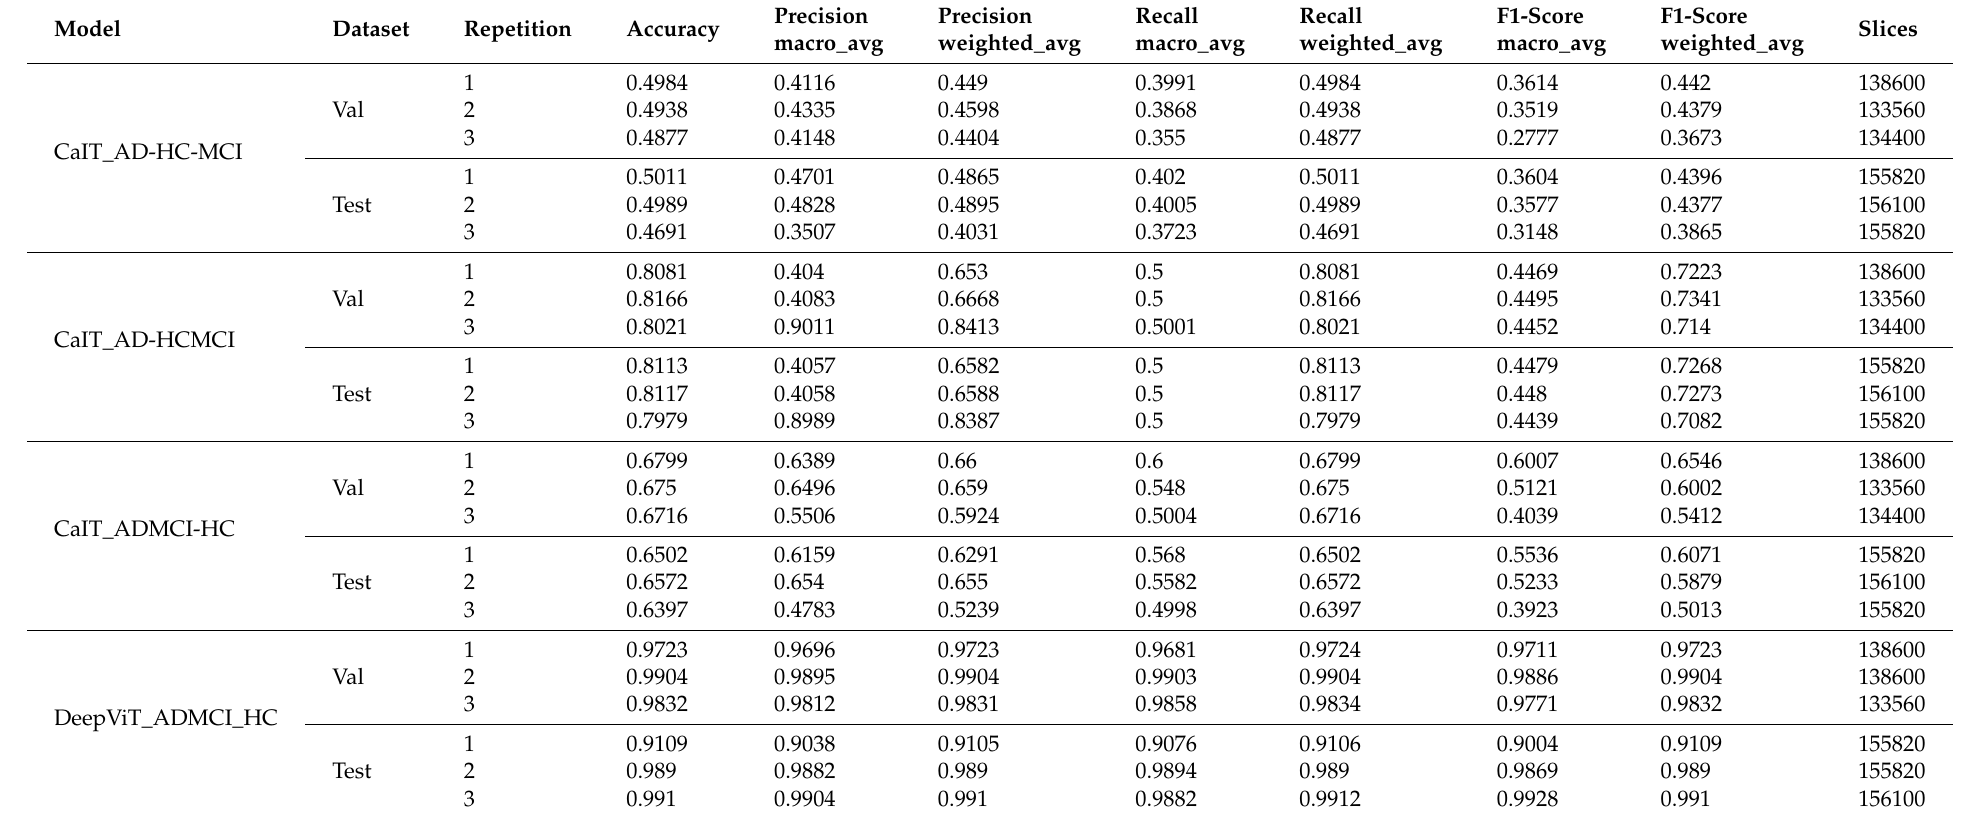
Table A1. The slice-level models’ performance is described in this table for the validation and test datasets and three repetitions (random data splits). The classification report includes the macro and weighted average precision, recall, and F1-score. The report also includes the accuracy rate and the number of unseen slices used for each model